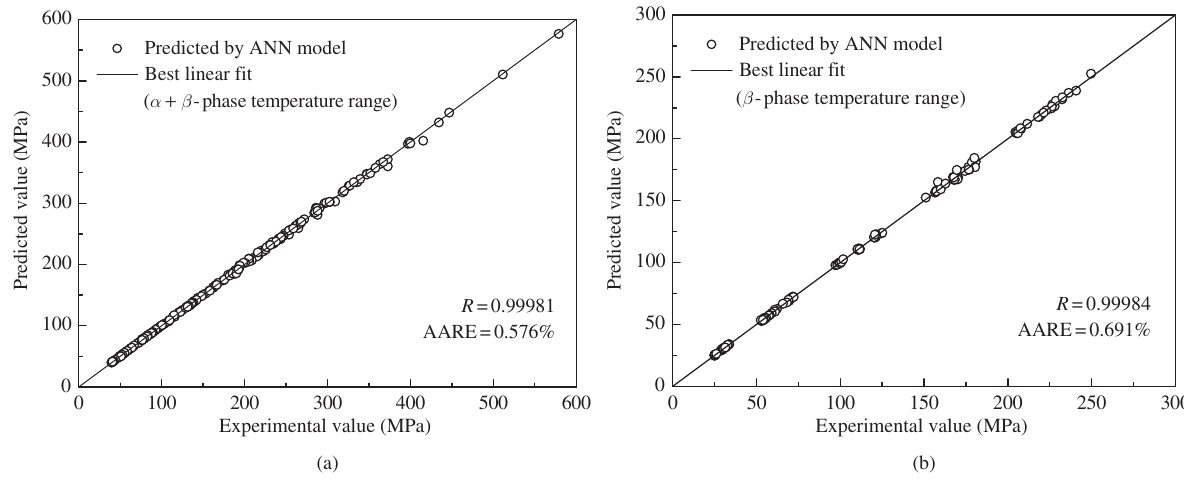
Figure 10 Correlations between experimental and predicted flow stress in testing procedure for (a) α þ β -phase temperature range, (b) β -phase temperature